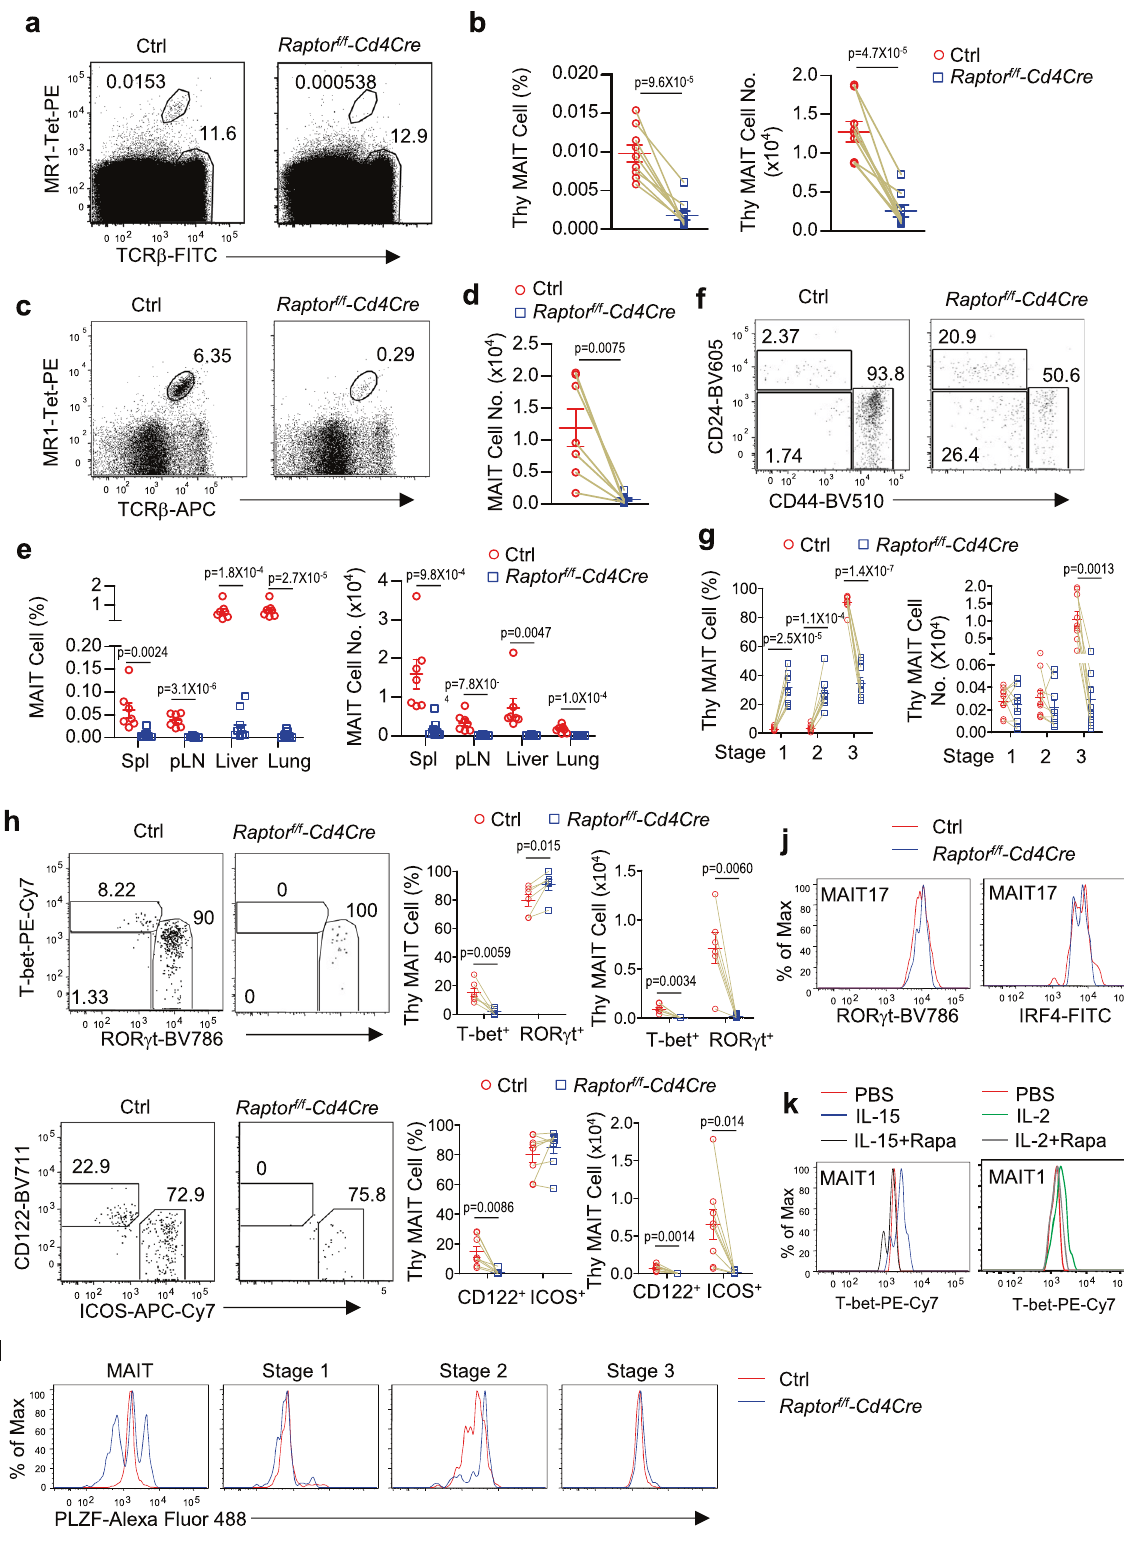
(Fig. 9i left panel) and a portion of ICOS + CD122 − MAIT17 cells but not ICOS − CD122 + MAIT1 cells turned into T-bet + ROR γ t + cells (Fig. 9i right panel). These data suggested that MAIT17 but not MAIT1 cells responded to in vitro IL-1 β and IL-23 for expansion and that T-bet + ROR γ t + MAIT cells were derived from ICOS + CD122 − ROR γ t + MAIT17